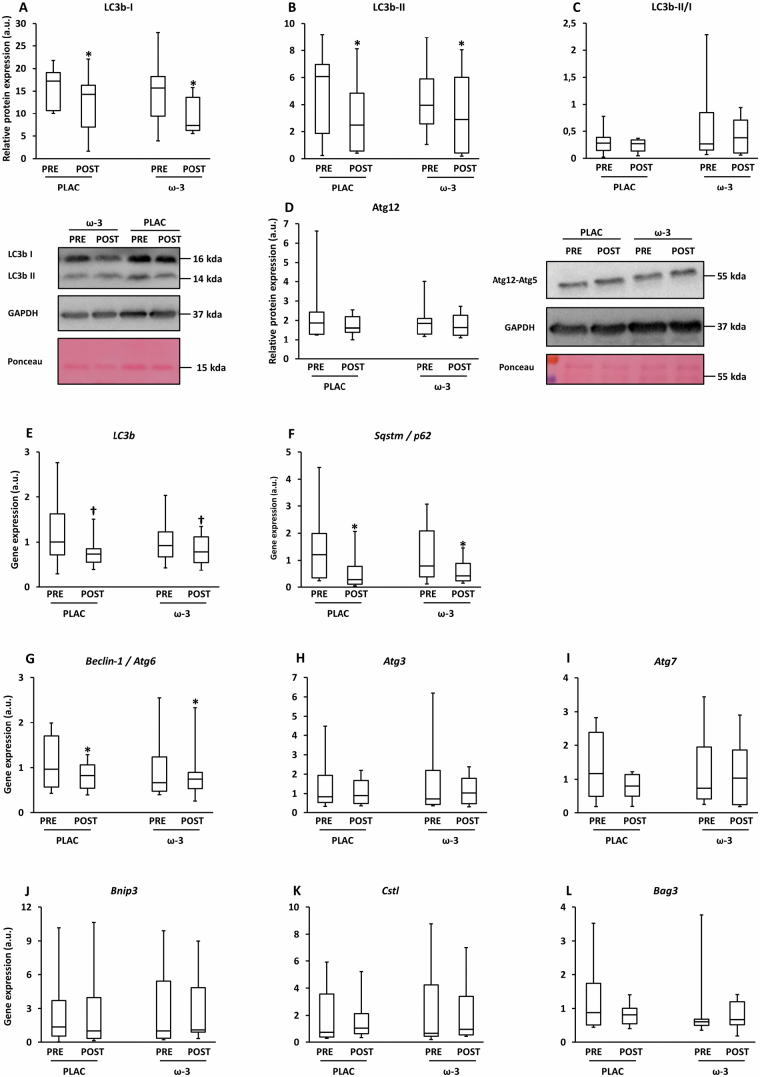
Expression of autophagy markers in skeletal muscle tissue before (PRE) and after (POST) 12-week resistance exercise in the placebo (PLAC) and omega-3 (ω-3) group. (A) Microtubule-associated proteins 1a/1b light chain 3b (LC3b) I protein expression, (B) LC3b-II protein expression, (C) LC3b II/LC3b I, (D) autophagy-related protein (Atg)5-Atg12 expression, (E) LC3b gene expression, (F) sequestosome-1 (Sqstm1) / p62 gene expression, (G) Beclin-1 / Atg6 gene expression, (H) Atg3 gene expression, (I) Atg7 gene expression, (J) Bnip3 gene expression, (K) Cathepsin L (Cstl) gene expression, (L) B-cell lymphoma 2–associated anthanogene (Bag3) gene expression. For all boxplots, the box represents the interquartile range, the horizontal line in the box represents the median, and the error bars represent the maximum and minimum values. Data were analyzed with a 2-way repeated measures ANOVA to detect differences over time (PRE vs POST) and between groups (PLAC vs Ω-3). *p < .05 (POST vs PRE); †p = .5–.1 (POST vs PRE).